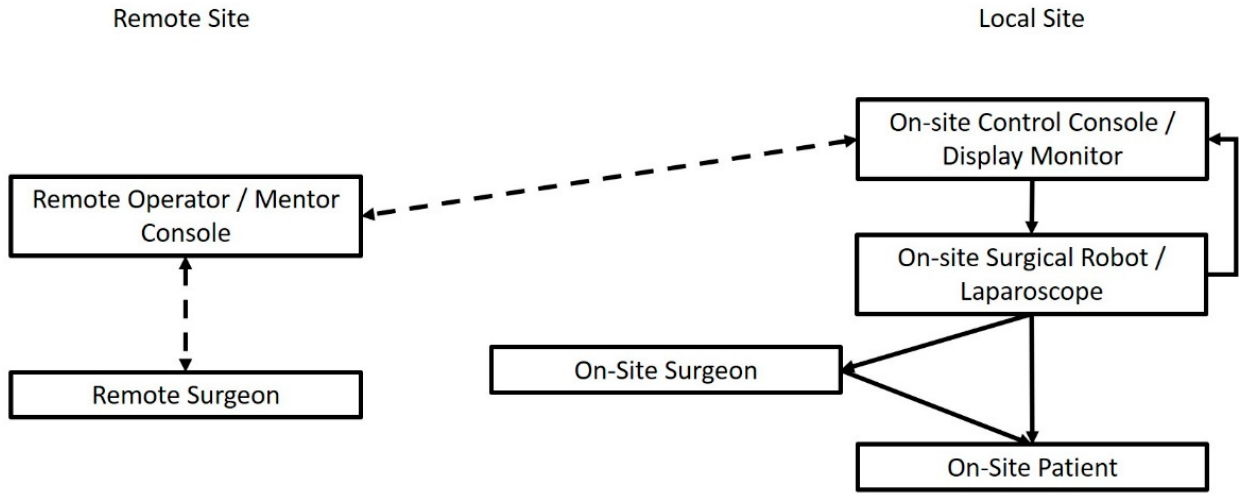
Figure 1. Connected IoST entities and workflow of an IoST-based Telementoring/Telesurgery Sys- tem .